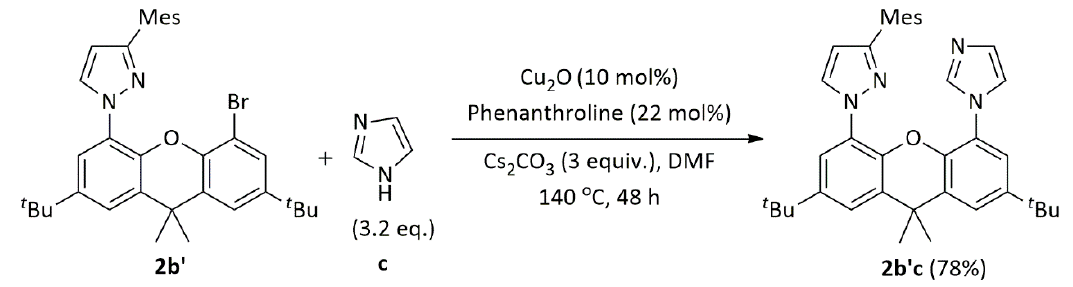
Figure 2. Molecular structures of 1 , 1a , 2a , 2b and 2b` with the key atoms labelled (thermal ellipsoids drawn at 50% probability). For clarity, hydrogen atoms have been omitted.